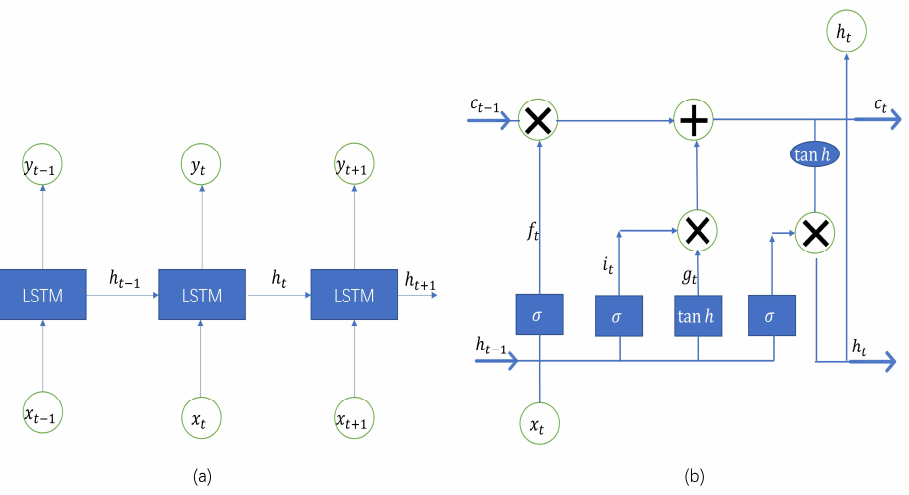
Figure 1. Architecture of long short-term memory [25]. ( a ) Architecture of long short-term memory. ( b ) Architecture of long short-term memory model memory unit.